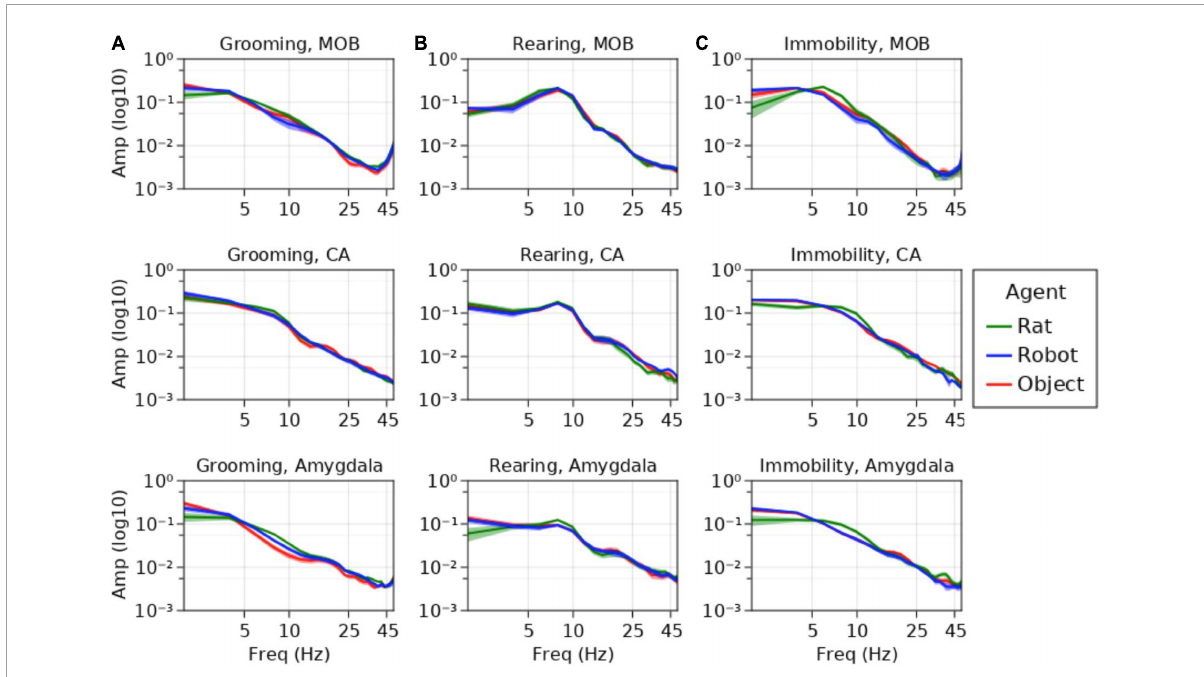
FIGURE8 Average power spectral densities for MOB, CA1/CA2, and amygdala for (A) grooming, (B) rearing, and (C) immobility events. Amplitude is represented on the y -axis, frequency is represented along the x -axis. Average amplitudes during interaction with rats is represented in green, robots in blue and objects in